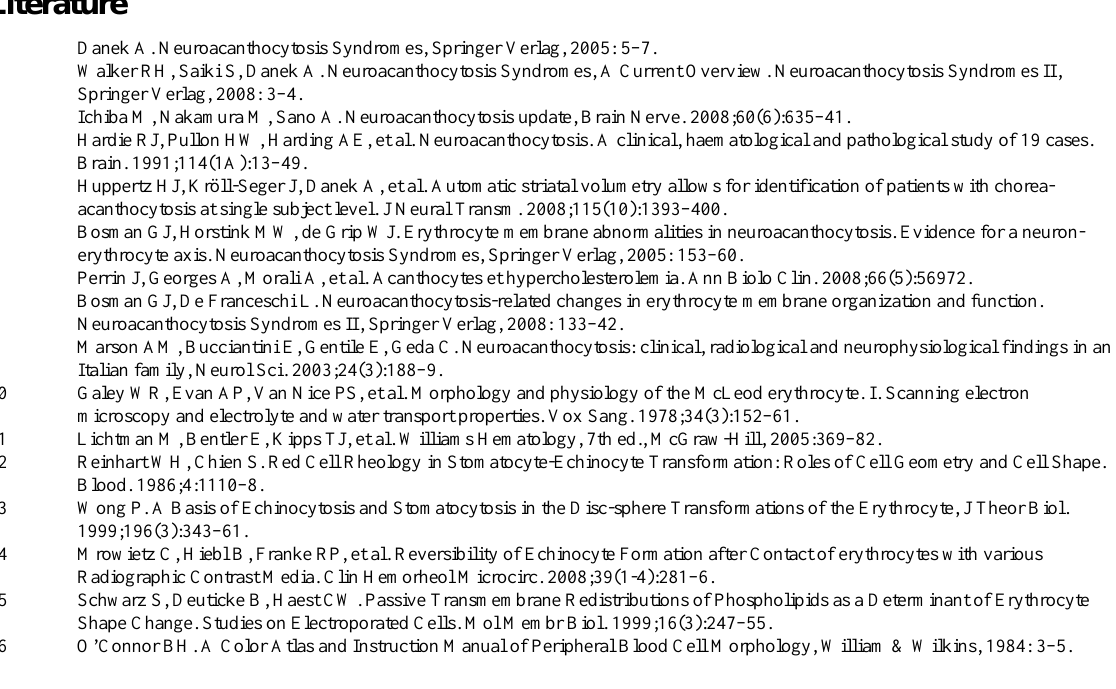
Figure 1 Chorea-acanthocytosis: acanthocytic (A) and echinocytic (E) deformation of RBCs. Figure 2 ChAc: peripheral blood smear: differentiating echino-/acanthocytes. Figure 3 ChAc: schizocyte (S), acanthocytes (A) and echinocytes (E) in